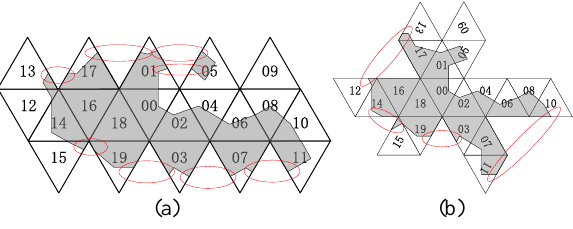
Figure 3. Fracture times comparison of the same area object between two different unfolding patterns. (a) Fracture processing operation for 8 times; (b) Fracture processing operation for 4